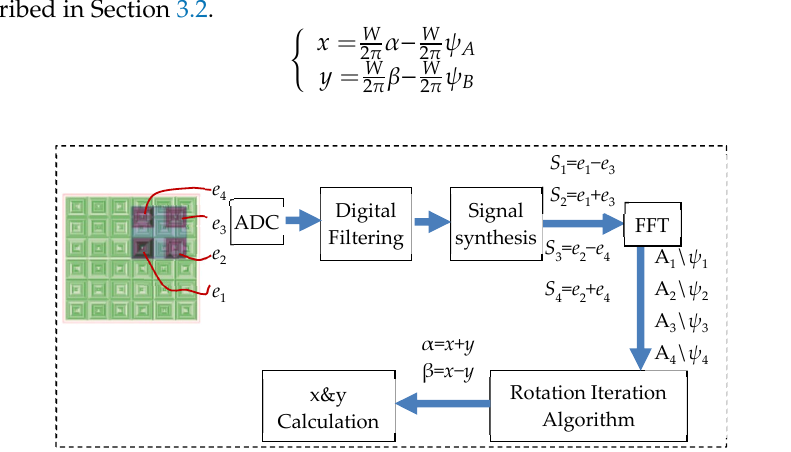
Figure 4. Processing of the electrical signals.